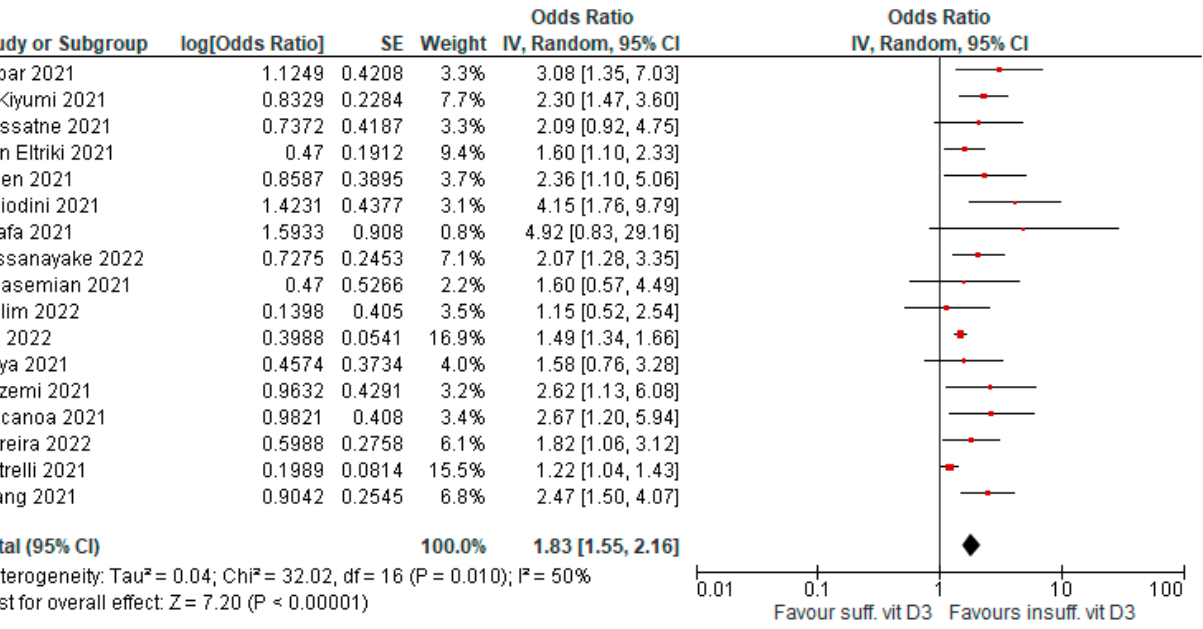
Figure 4. Forest plot showing results for the association of vitamin D3 levels and COVID-19 mortality.